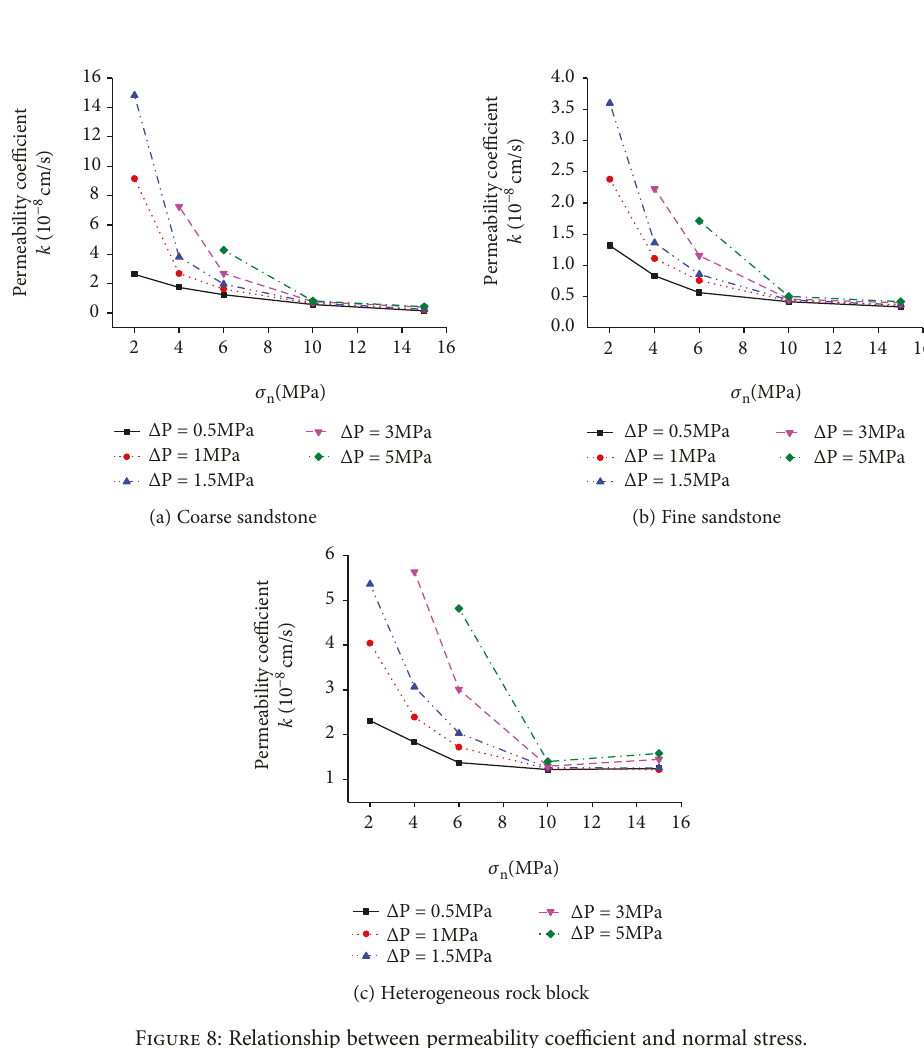
Figure 8: Relationship between permeability coe ffi cient and normal stress.